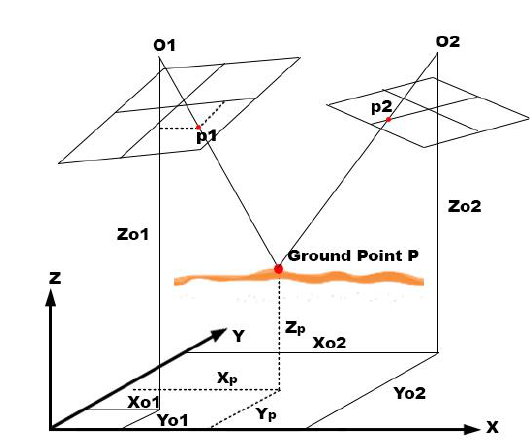
Figure 14. Illustration of space intersection in photogrammetry (Mikhail et al.,